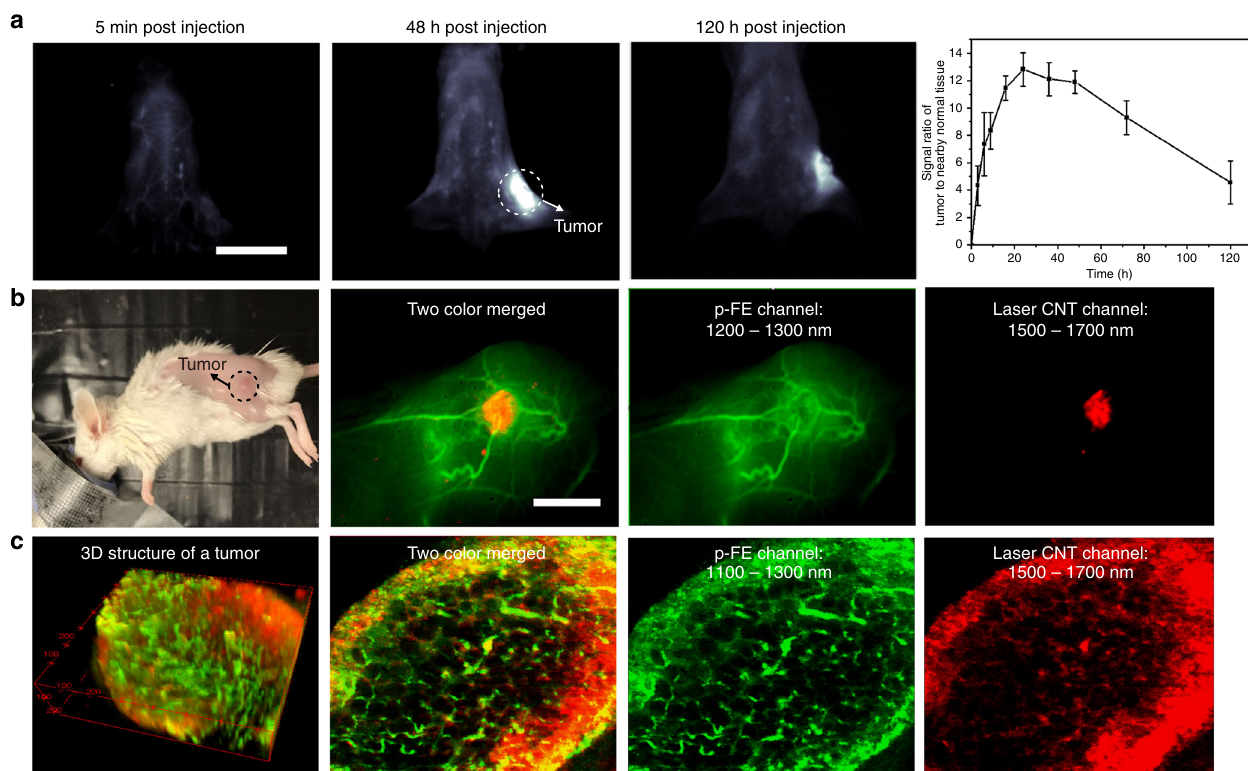
Fig. 4 Two-color fl uorescence imaging of a tumor in the NIR-II window. a Wide- fi eld fl uorescence imaging of a mouse inoculated with a 4T1 tumor through collection of fl uorescence emitting from p-FE above 1300 nm with exposure time of 5 ms and variation of T/NT signal ratio as a function of time ( n = 3). b High-magni fi cation fl uorescence imaging of a mouse inoculated with a 4T1 tumor using two colors in the NIR-II window. c Confocal imaging of a tumor using two colors in the NIR-II window. 740 µ m × 740 µ m × 220 µ m area, step size: 2 µ m along x and y directions, 5.4 µ m along z direction. Laser power ~30 mW, PMT voltage: 500 V for p-FE channel and 600 V for laser CNT channel, scanning speed 15 min/frame. Pin hole: 150 µ m for p-FE and 300 µ m for laser CNT channel. Wavelength range: 1100 – 1300 nm for p-FE channel and 1500 – 1700 nm for laser CNT channel. Scale bars in Figs 1a and 2b represent 2 cm and 6 mm, respectively. Error bars correspond to standard